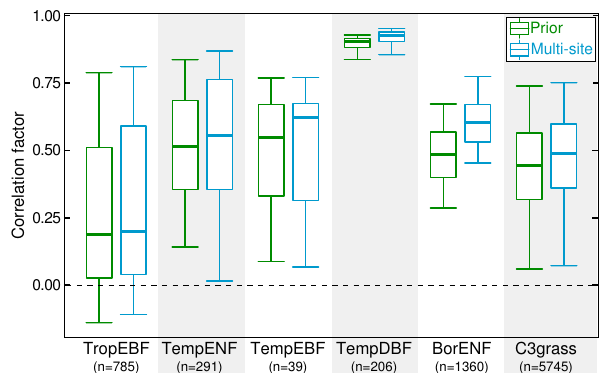
Figure 7. Correlation factor between weekly time series of mod- elled FAPAR and independent measurements of NDVI, for the 2000–2010 period. The results are grouped using the dominant PFT at each pixel, for global simulations with default (green) and mul- tisite parameterization (blue). The central horizontal bar indicates the median value, the top and bottom of the boxes correspond to the first and last quartile, and the 5th and 95th percentiles are given by the “error